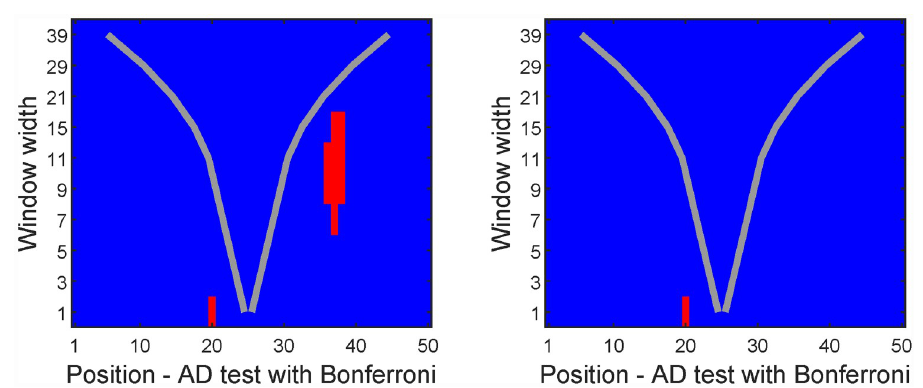
Fig 5. Significance maps of the scale-space multinormality test for the data of the Introduction. Left/Right: Significance level of 0.005/0.001.